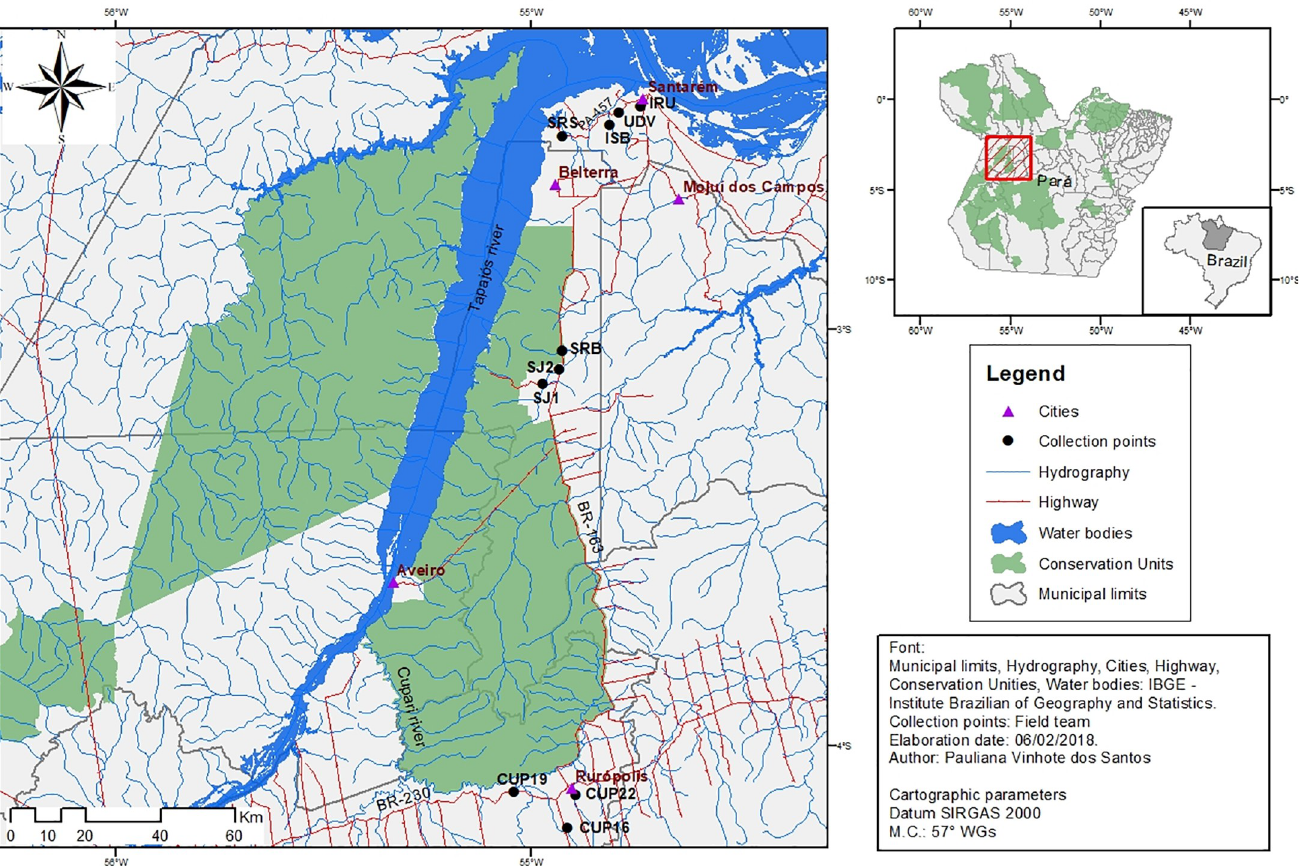
Fig 1. Map of collection sites of stream ichythyofauna at the region of lower Tapajo´s